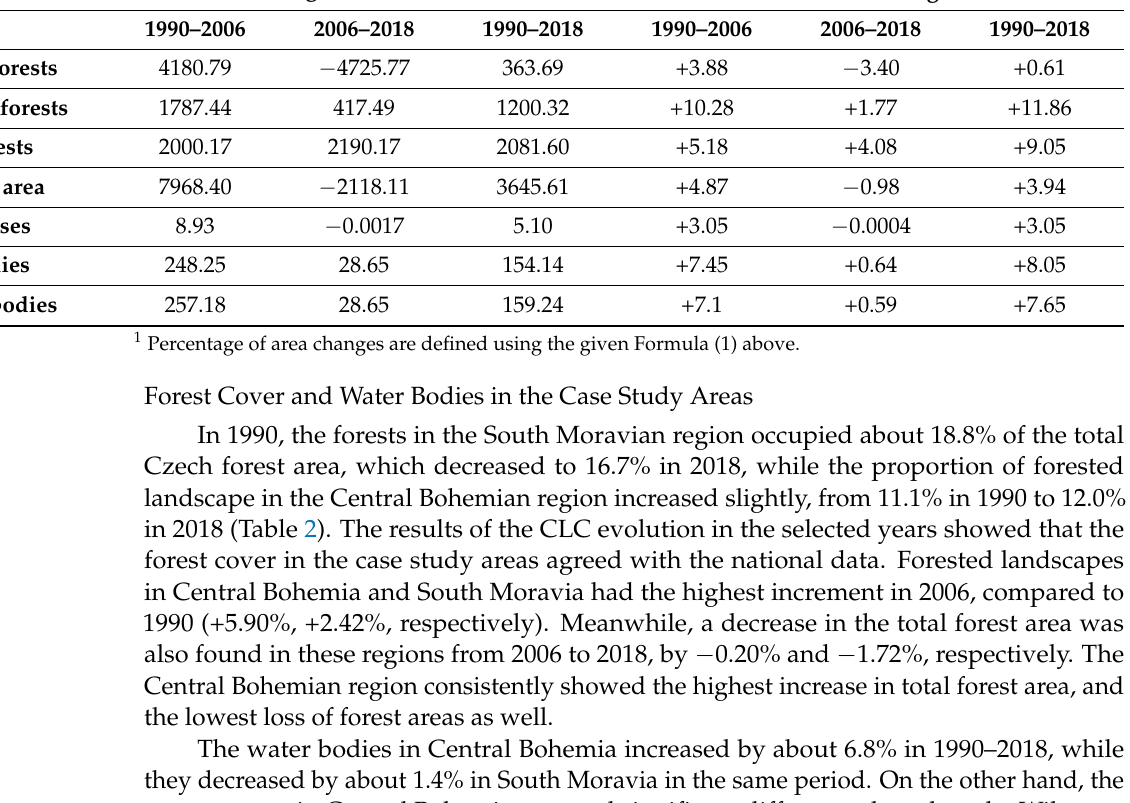
Table 3. Forest cover and water body changes from 1990 to 2006 and 2006 to 2018 and 1990 to 2018 in the Czech Republic. Type of Land